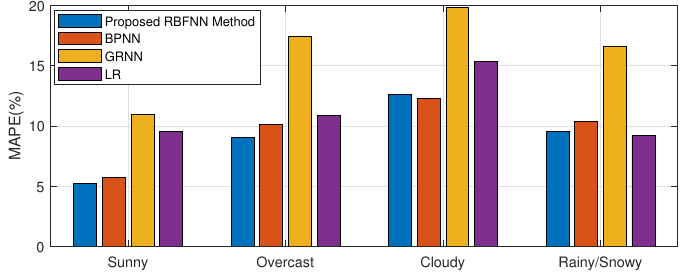
Figure 13. The mean absolute percentage errors (MAPEs) of four PV forecasting models.